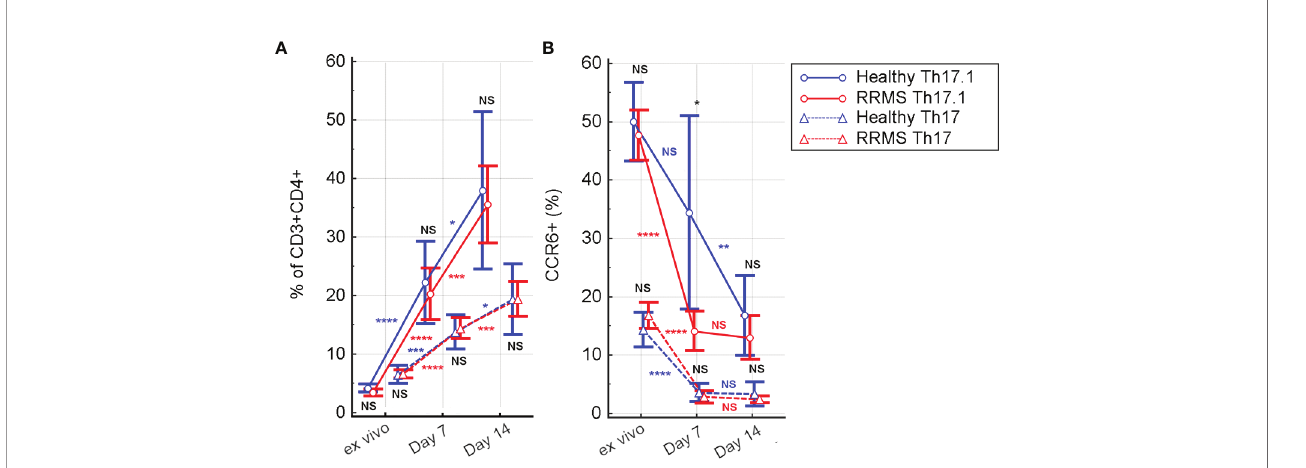
FIGURE 5 | The evolution of Th17 (CD3+CD4+CD161+CXCR3 − ) and Th17.1 (CD3+CD4+CD161+CXCR3+) cell subpopulations (A) and of CCR6 positive Th17 and Th17.1 cells (B) from ex vivo to 7 and 14 days in culture with rh-IL2. Signi fi cance levels are graphically represented as follows: NS, non signi fi cant, p >0.05, * p <0.05, ** p <0.01, *** p <0.001, **** p <0.0001.